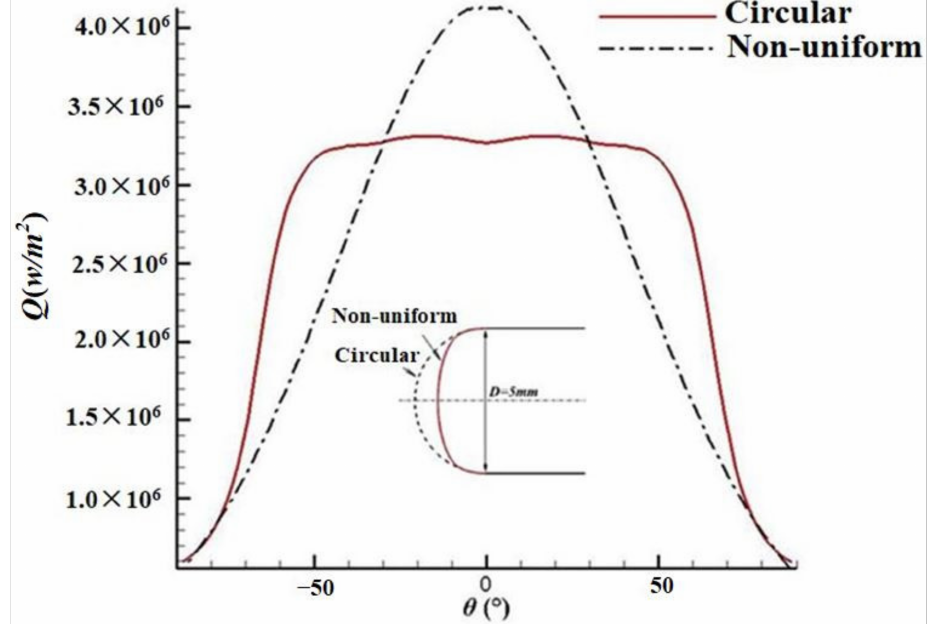
Figure 1. Heat flow distribution of circular and non-uniform leading edge